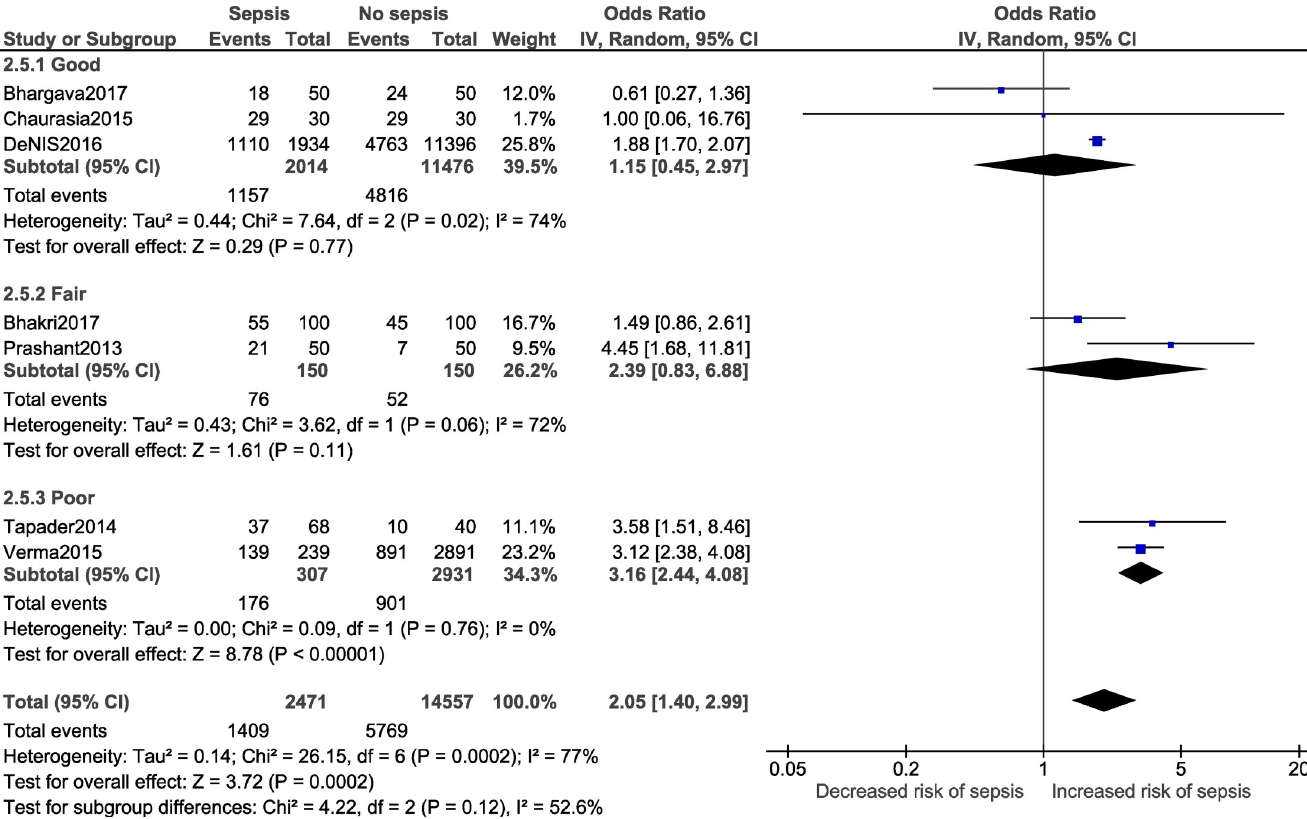
Fig 17. Forest plot showing random-effects meta-analysis of neonates, with and without sepsis, born to mothers delivering < 37 weeks of gestation, sub-grouped by study quality (7 studies) [IV: Inverse Variance; CI: Confidence Interval].